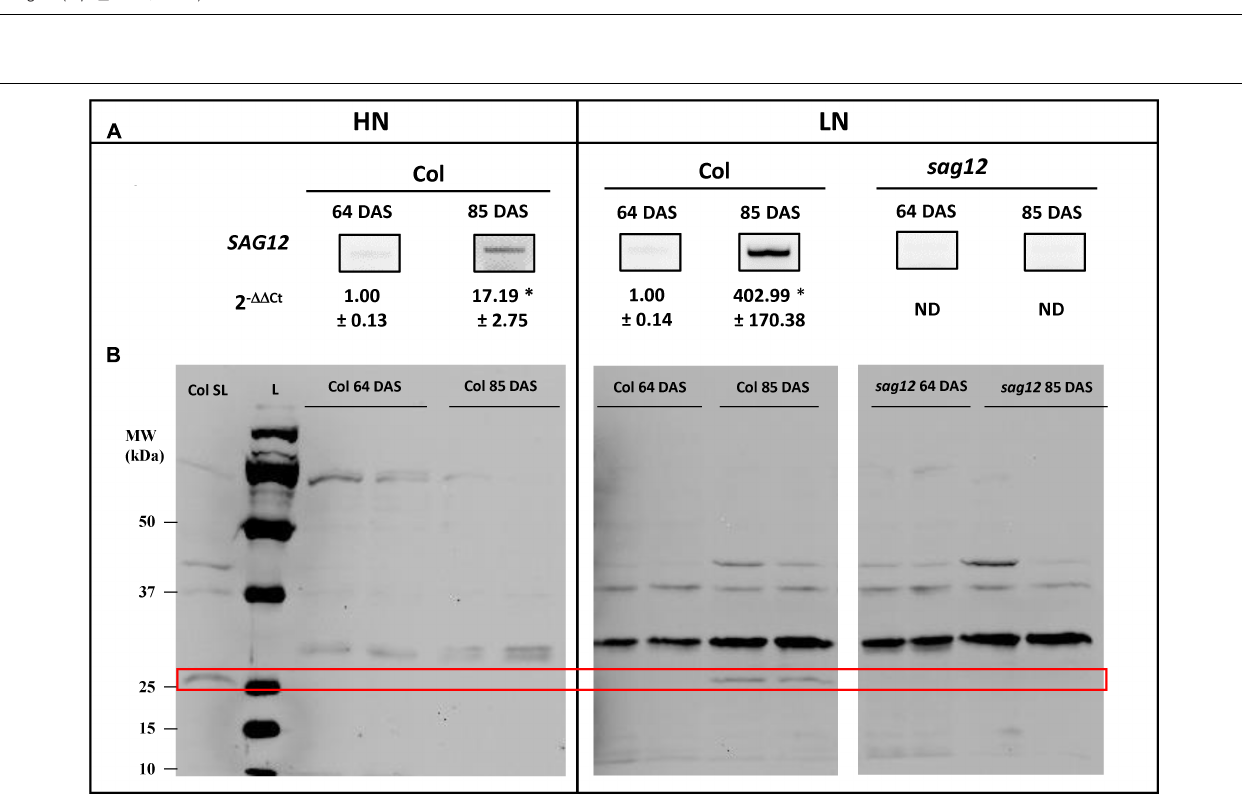
Frontiers in Plant Science |